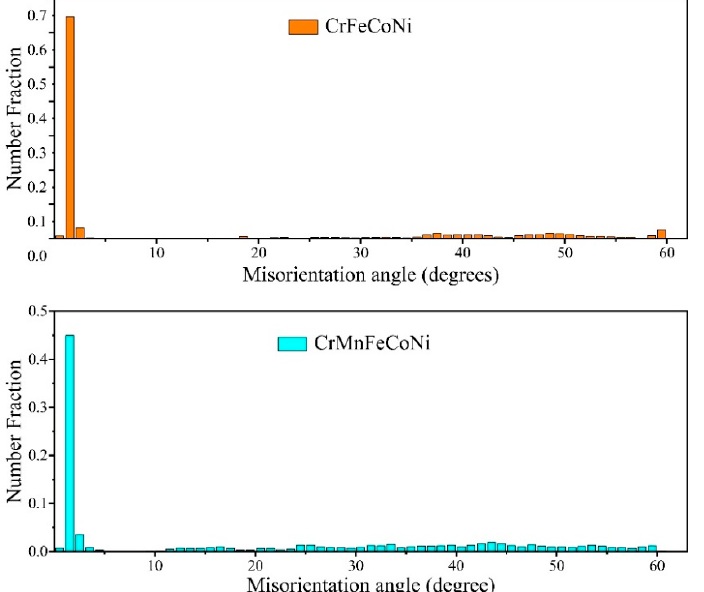
Figure 2. Histogram representing misorientation angle distribution of the CrFeCoNi and CrMnFe- CoNi coatings.